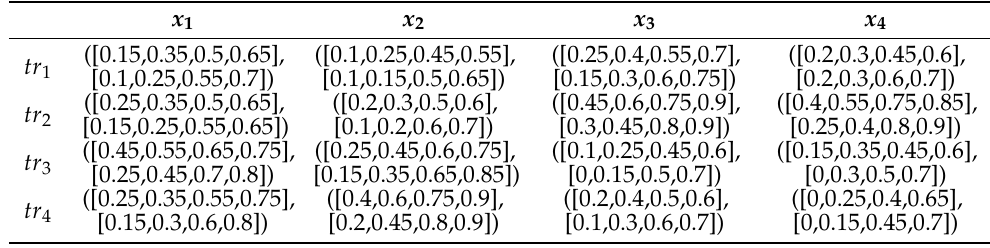
Table 2. Expert r 2 ’s decision matrix ˜ D 2